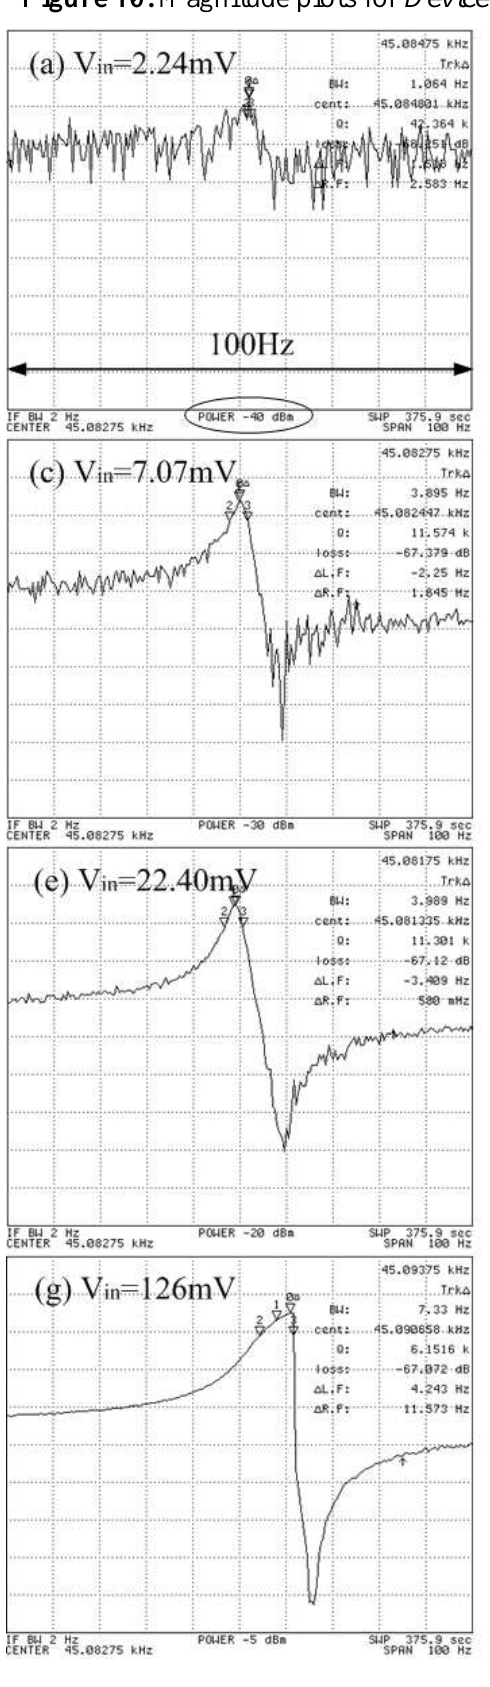
Figure 10. Magnitude plots for Device D